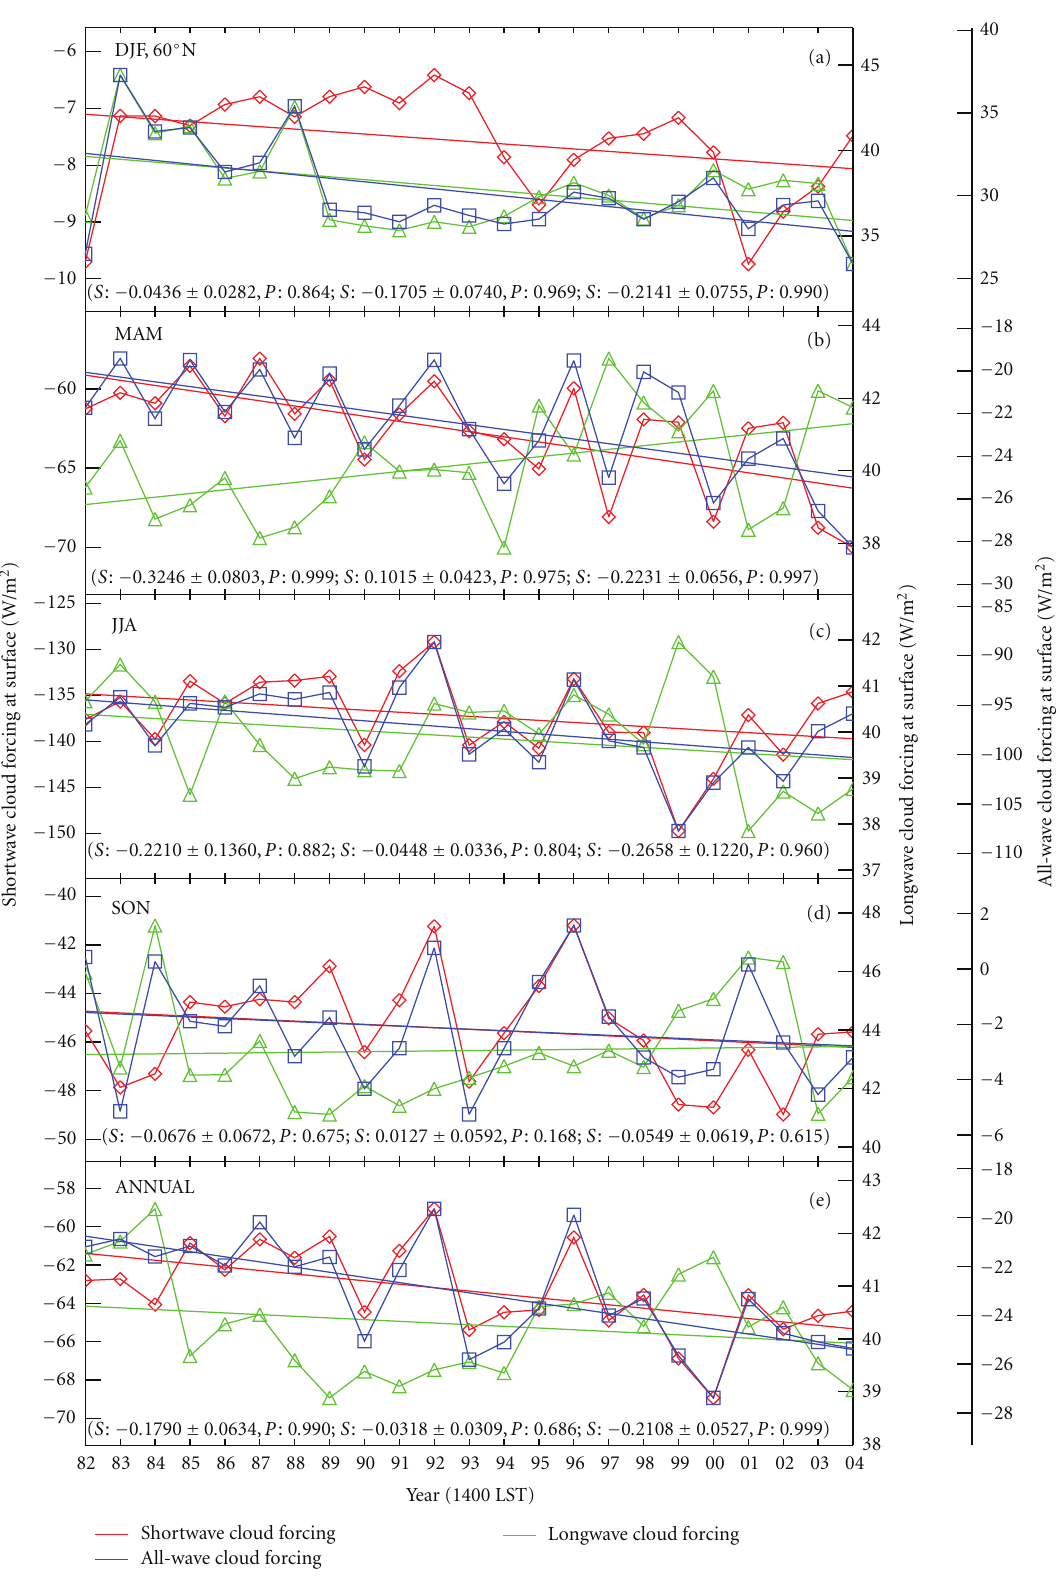
Figure 11: As in Figure 3, but for shortwave, longwave, and all-wave cloud forcing at the surface. The first pair of S and P denotes the shortwave cloud forcing trend (red), the second pair is for the longwave cloud forcing trend (green), and the third pair represents the all-wave cloud forcing trend